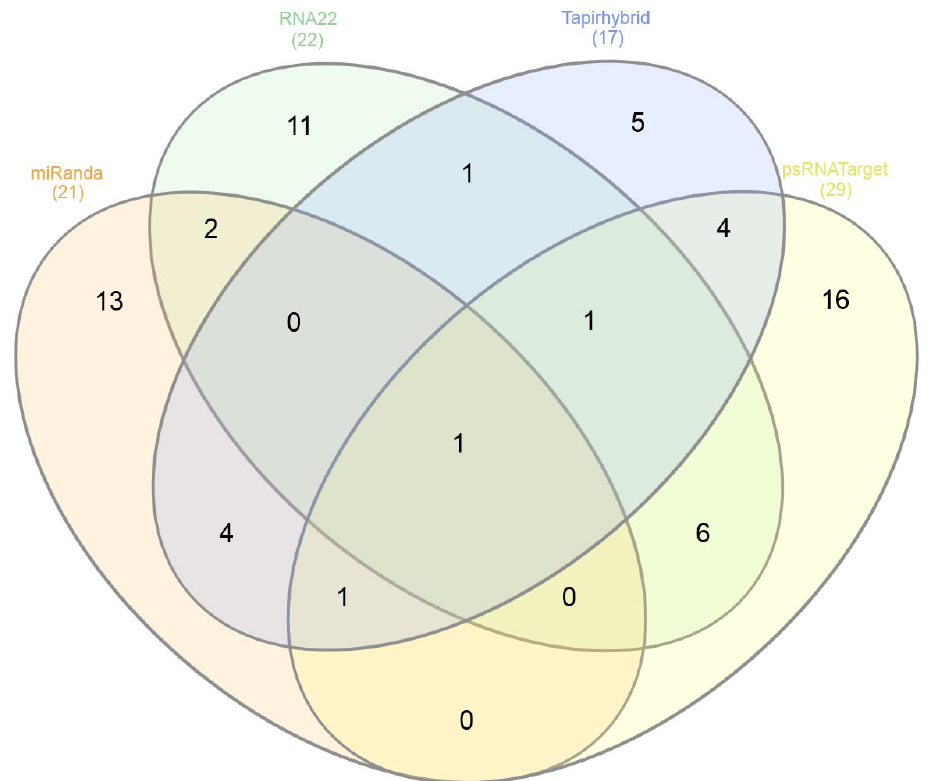
Figure 1. Venn diagram of cassava locus-derived mes-miRNA-target pairs predicted to bind the ICMV-Ker genome. The miRanda, RNA22, Tapirhybrid, and psRNATarget databases were mined to predict potential binding sites of cassava locus-derived mes-miRNAs. The degree of overlap between computational tools was observed at potential target-binding site level. The intersection of four tools’ graph showed a single common miRNA: mes-miR1446a.